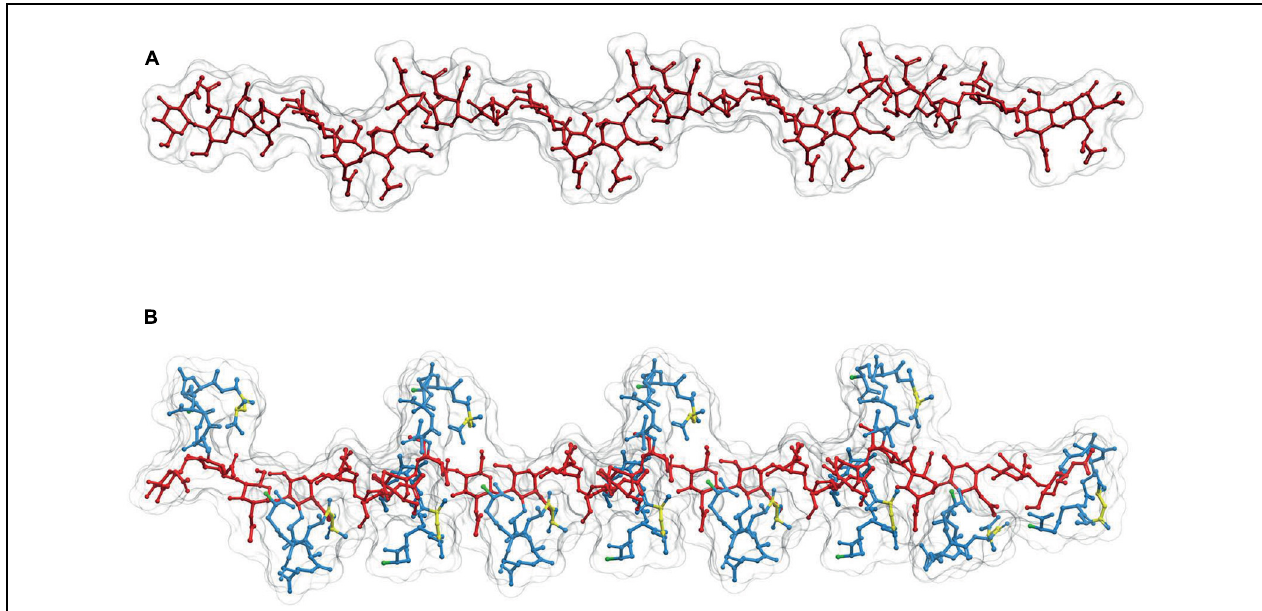
FIGURE 3 | Structure of linear PG polymers. (A) Sugar backbone for a 12-mer linear PG polymer, with a helical pitch of three subunits/turn. The backbone is derived from the structure of (B) a PG strand made up of 12 M5